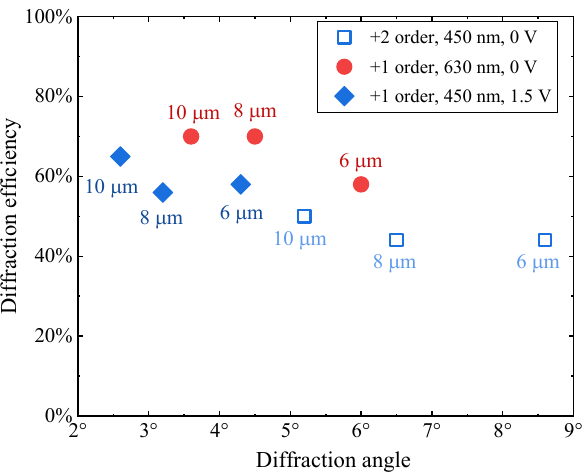
Figure 4. Diffraction angle dependence of the efficiencies of +2 order (hollow symbols) and +1 order (filled symbols) manifested by the three fabricated LC-metasurfaces at the target wavelengths of 450 nm (blue symbols) and 630 nm (red symbols) with the metasurface periods